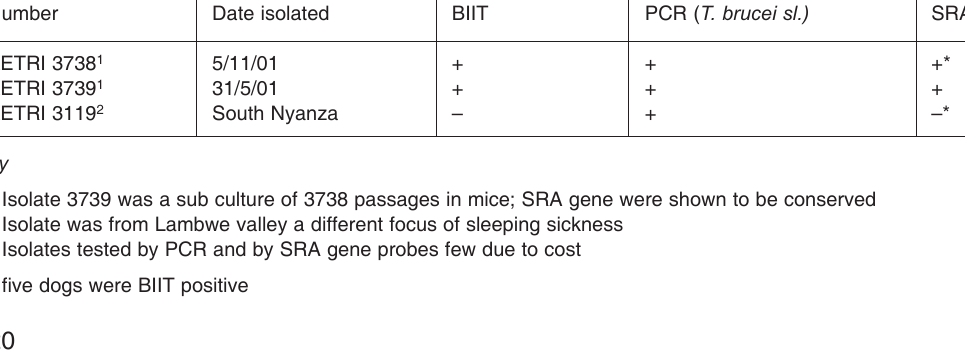
TABLE 1 Response of dog stabilates to BIIT and SRA gene probe Number Date isolated BIIT PCR ( T. brucei sl.) SRA